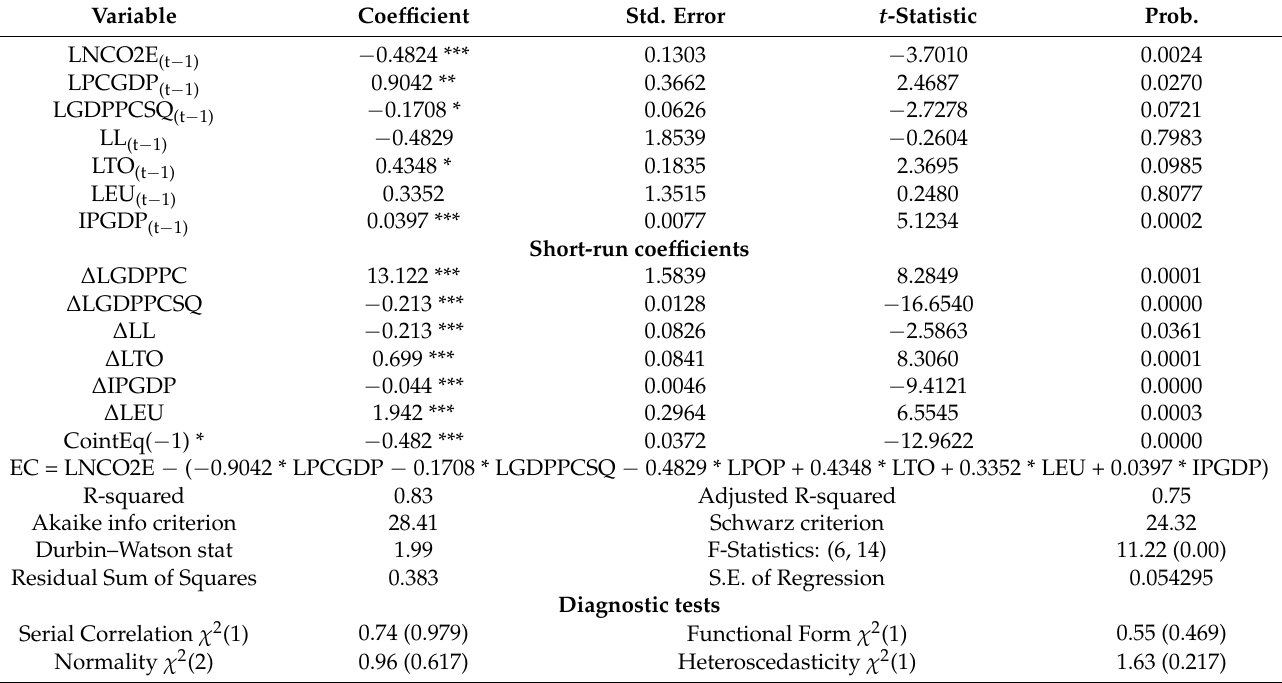
Table 3. Long Run coefficients from standard ARDL